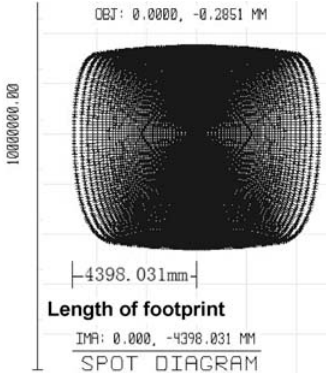
Figure 10. Simulated footprint at a flying height of 300 m above local average elevation 5.